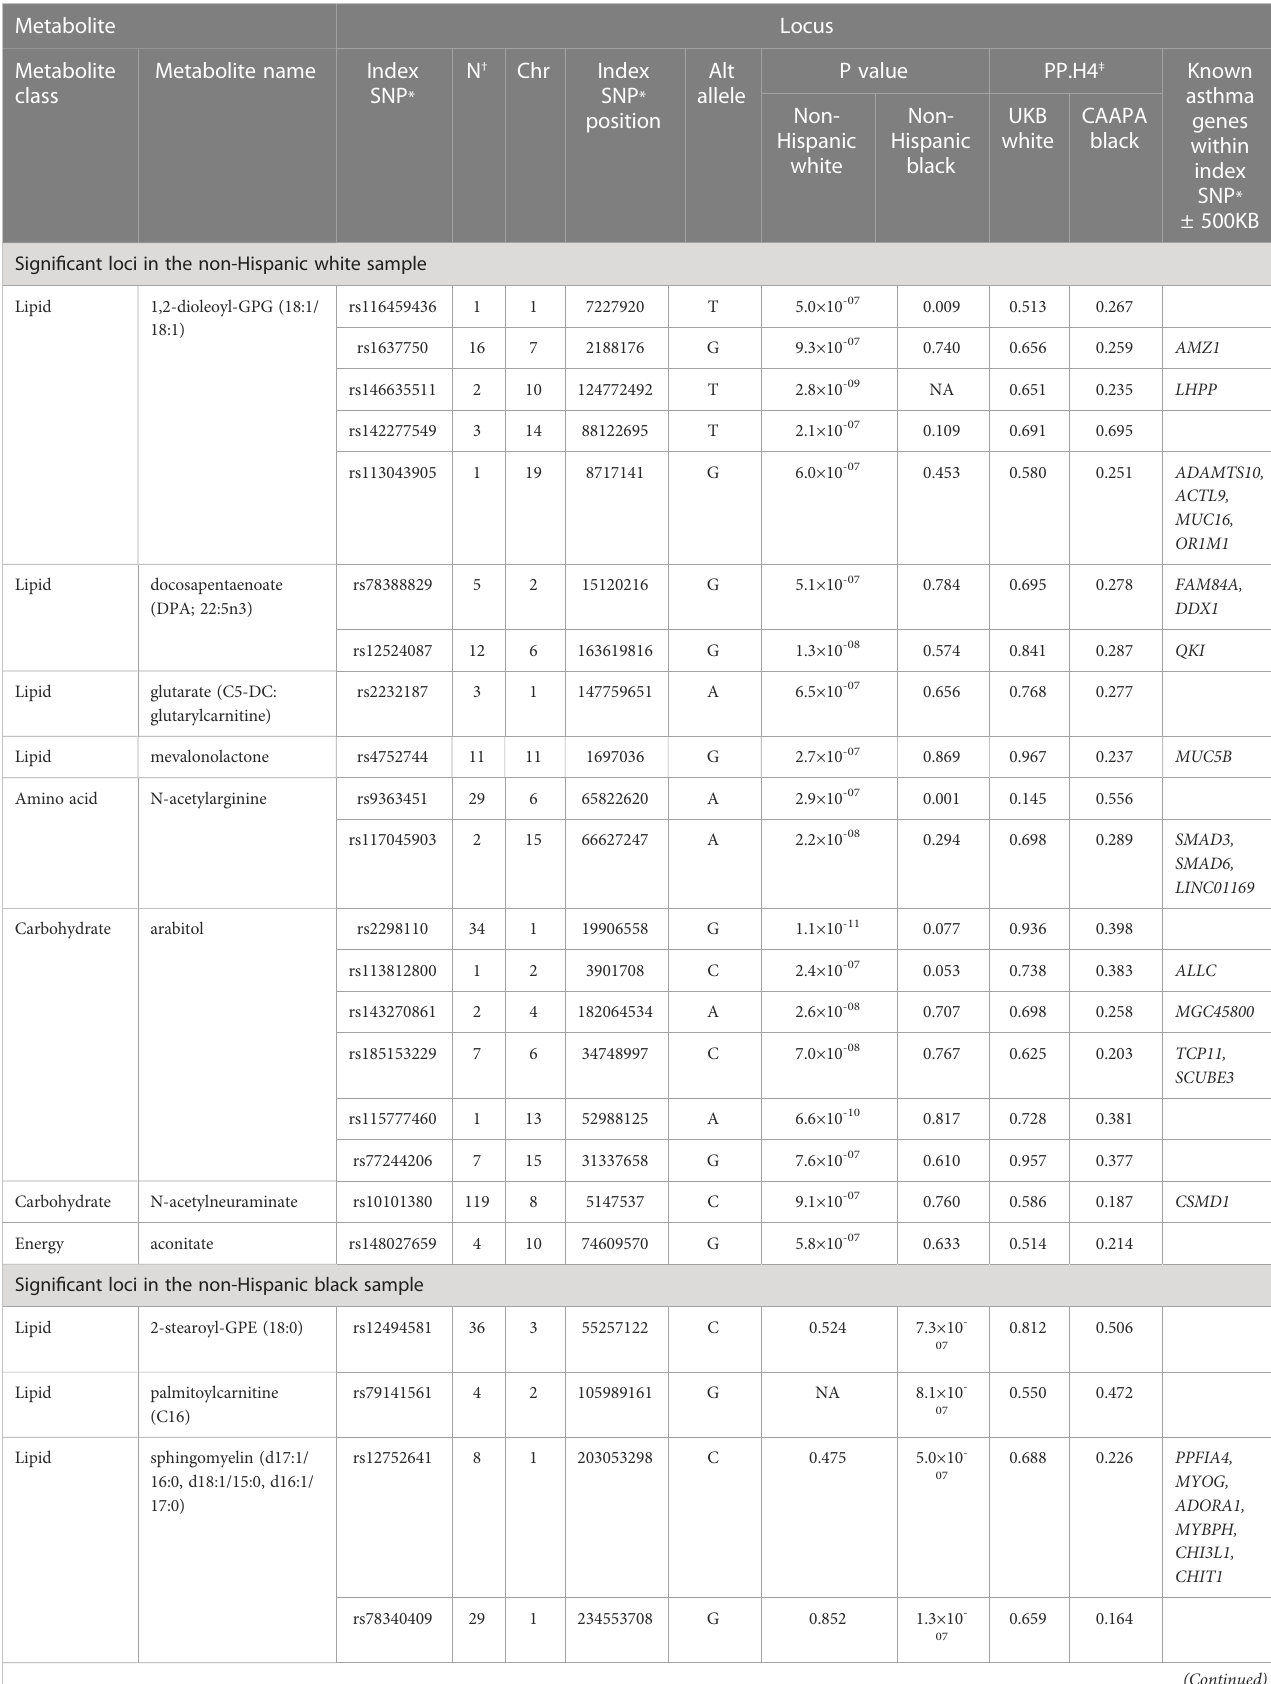
TABLE 2 Summary of the 30 genetic loci associated with both the candidate metabolites and asthma risk. Metabolite Locus Metabolite